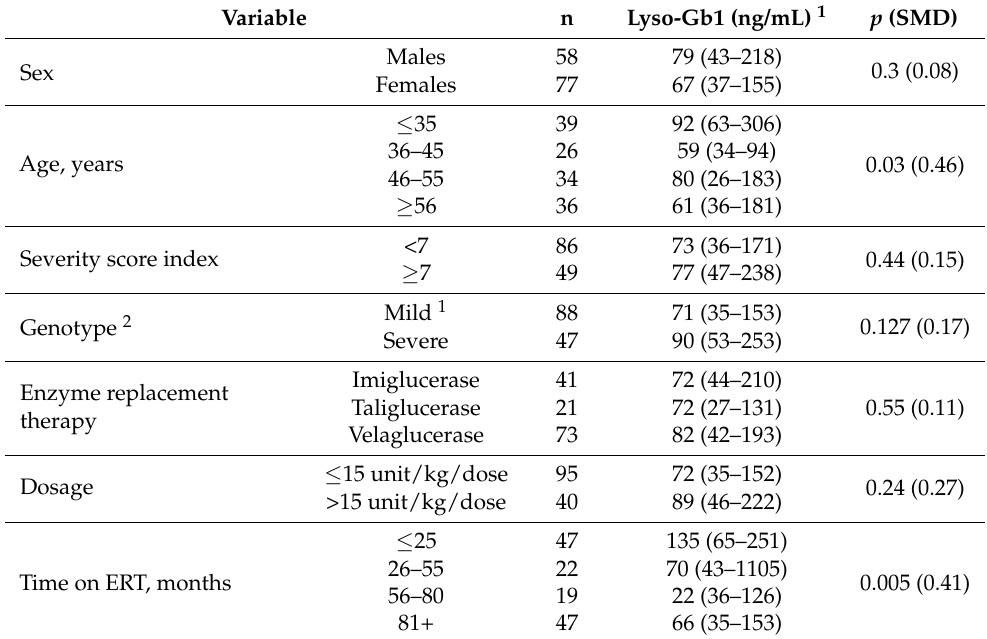
Table 2. Associations of covariables with lyso-Gb1 levels at the first time point